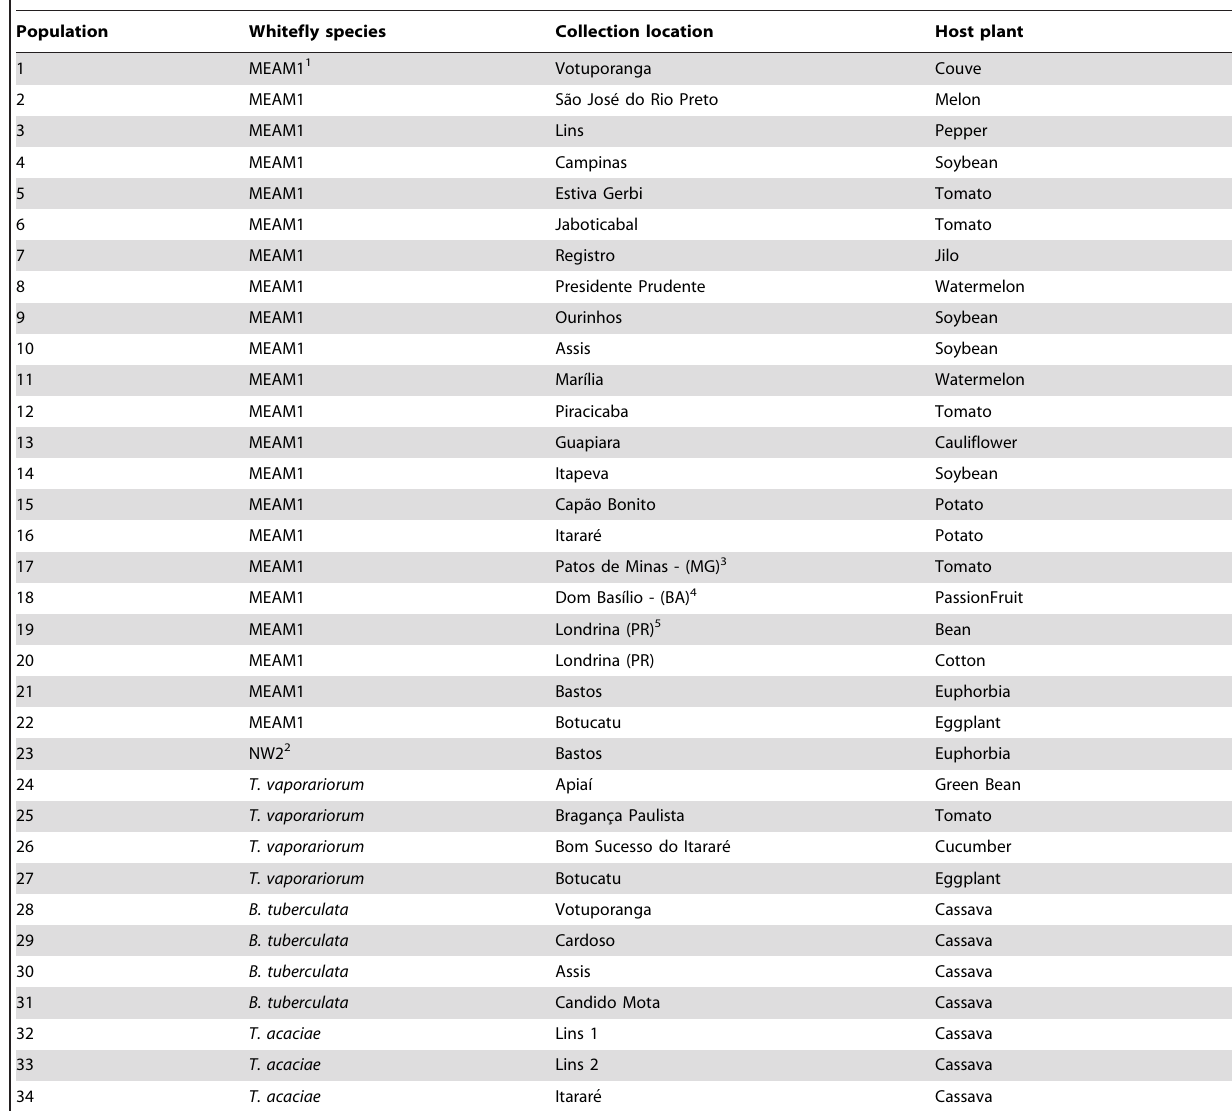
Table 1. Whitefly species collected and tested in this study.